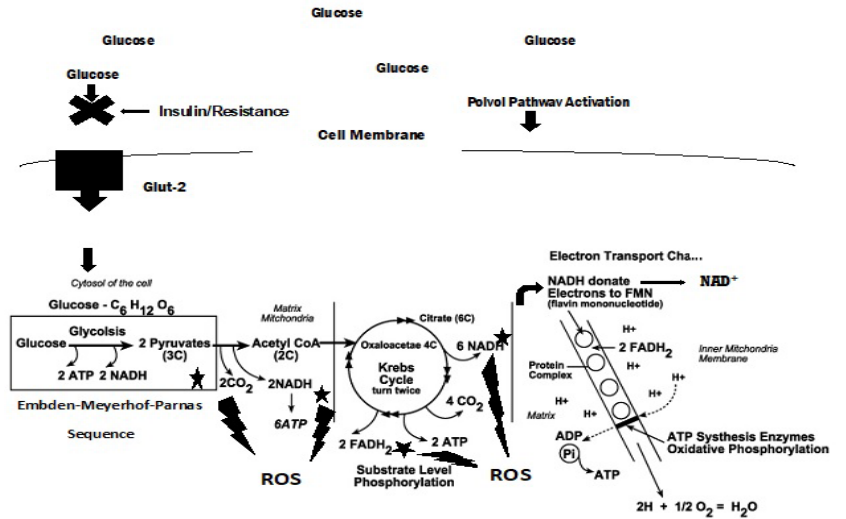
Figure 4. Hyperglycemic, insulin-resistant glucose metabolism. Although ROS are shown being formed at the starred sites of glucose metabolism, the actual formation of ROS occurs as electrons are being transferred from NADH and FADH 2 down the ETC through complexes I, II, III and